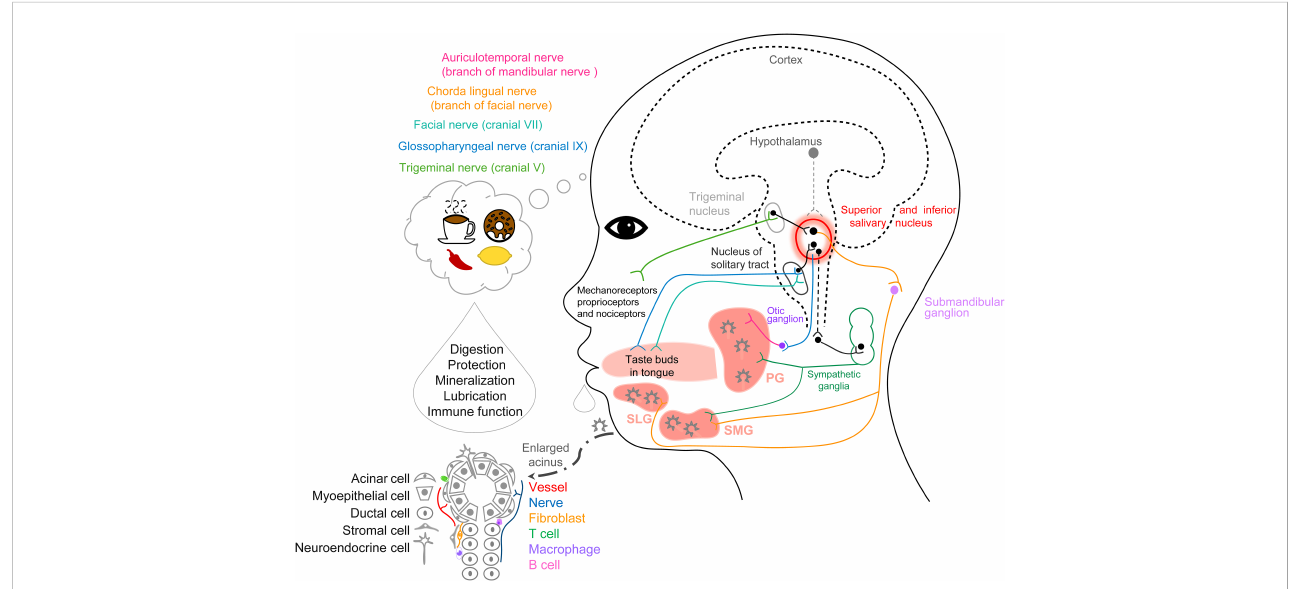
FIGURE 1 Schematic graph of anatomy, histology, and cell types for the salivary glands and the neurocircuits of saliva